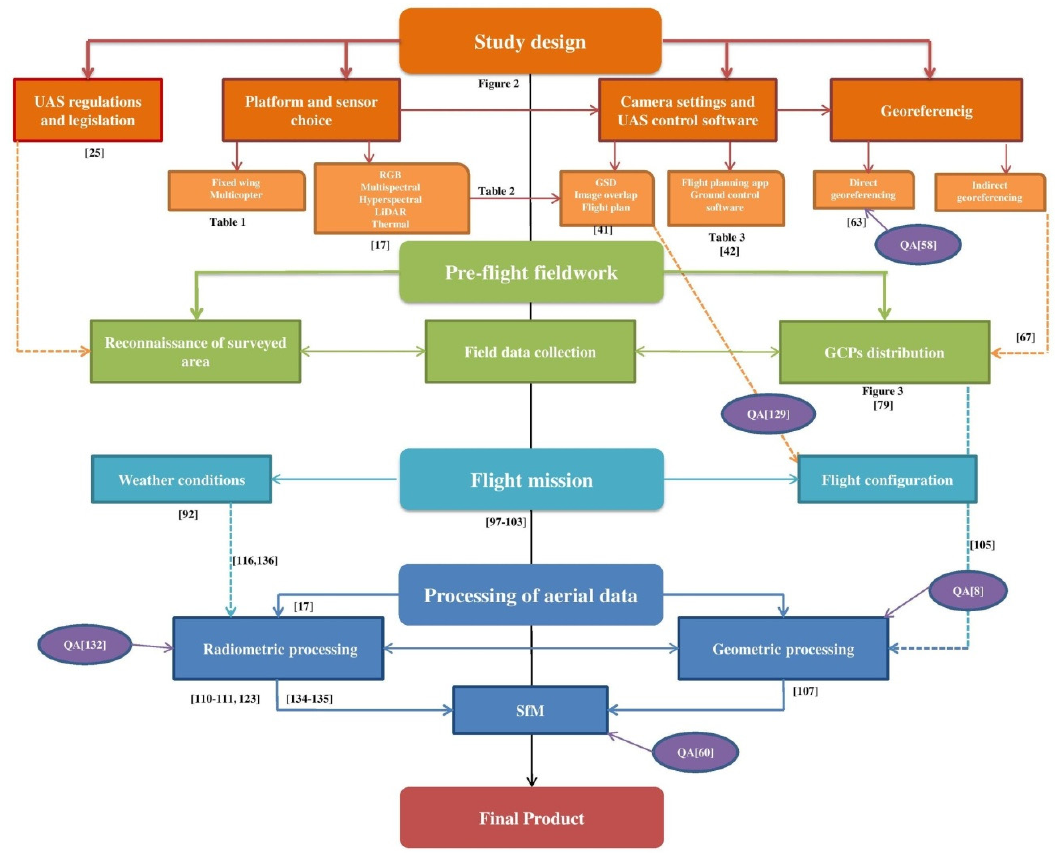
Figure 4. Proposed UAS environmental mapping workflow (n.b. QA refers to quality assurance).